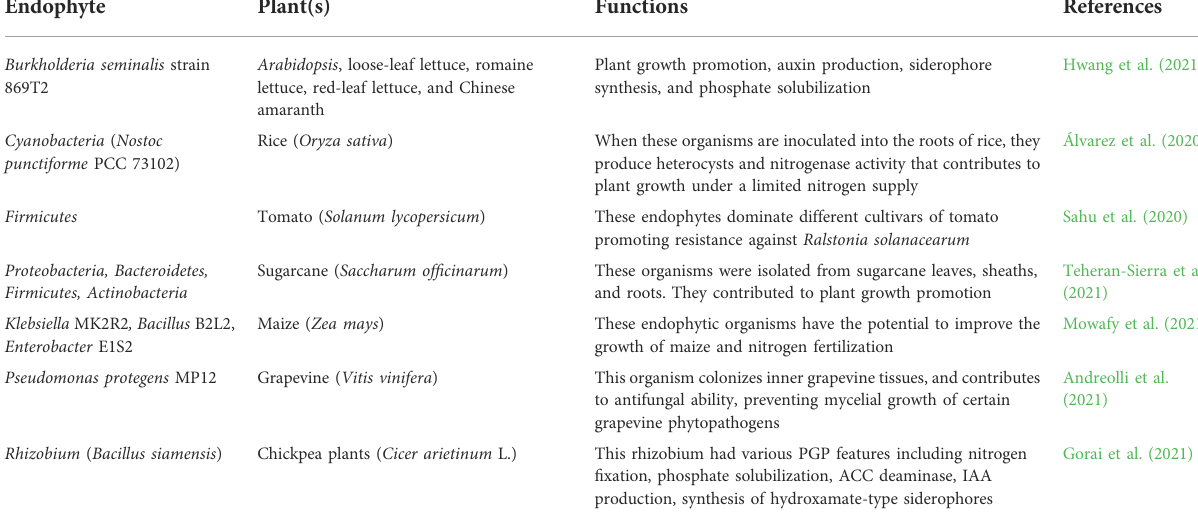
TABLE 3 Various endophytic microbes inhabiting crop plants and their